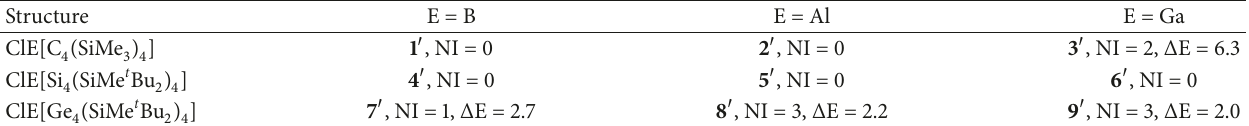
Table 2: Numbers of imaginary frequencies (NI) and relative energies towards closest minima ( (cid:2) E, kcal mol −1 ) for pyramidal systems 1 󸀠 –9 󸀠 .